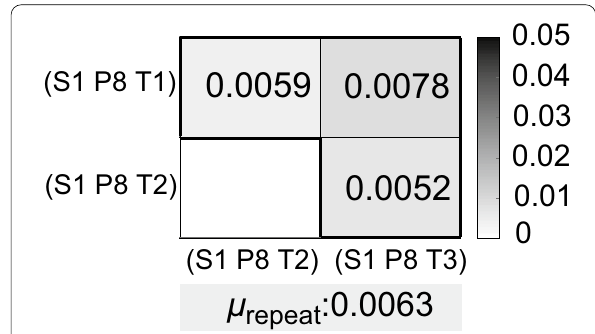
Fig. 8 Measurement reproducibility